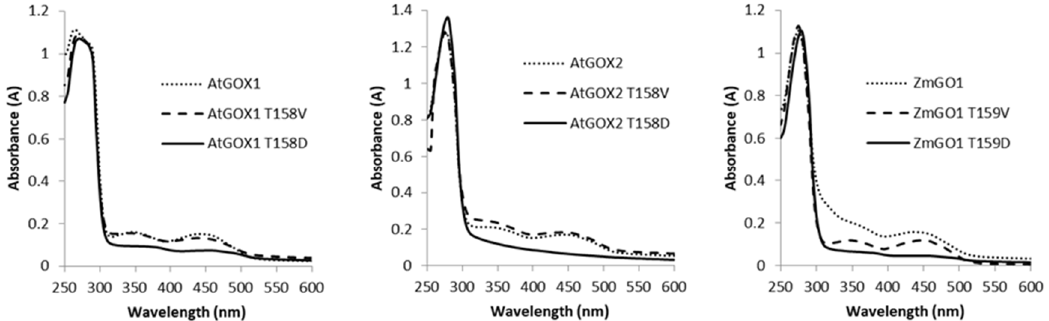
Figure 1. Absorption spectra of recombinant At GOX1, At GOX2 and Zm GO1 and their T158 / T159 phospho-site mutated forms.